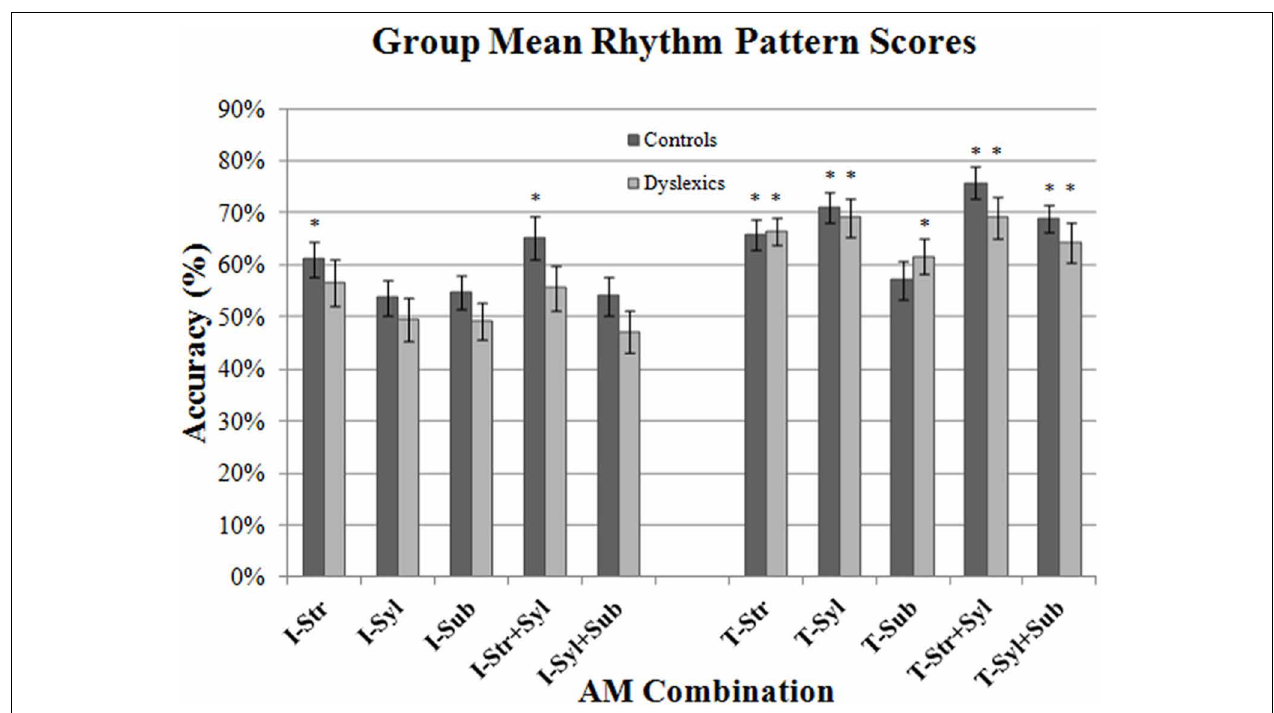
FIGURE 5 | Group mean Rhythm Pattern scores for each AM band and band combination, shown separately for iambic (“I”: Ives & Queen) and trochaic (“T”: Mary & Simon) sentences. Error bars indicate standard error. ( ∗ ) AM bands where performance was above chance (50%) for each